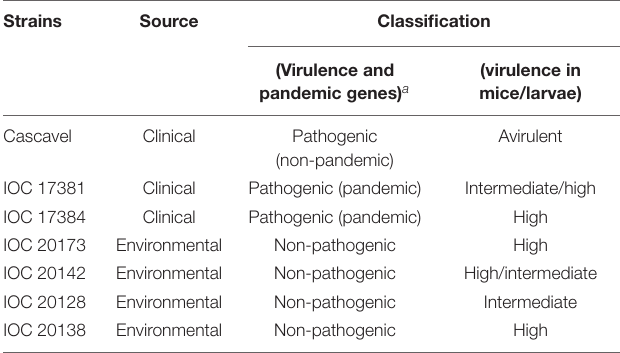
TABLE 5 | Classification of the Vibrio parahaemolyticus strains analyzed in this work based on phenotypic and genotypic characteristics and virulence in mice and Galleria mellonella models of